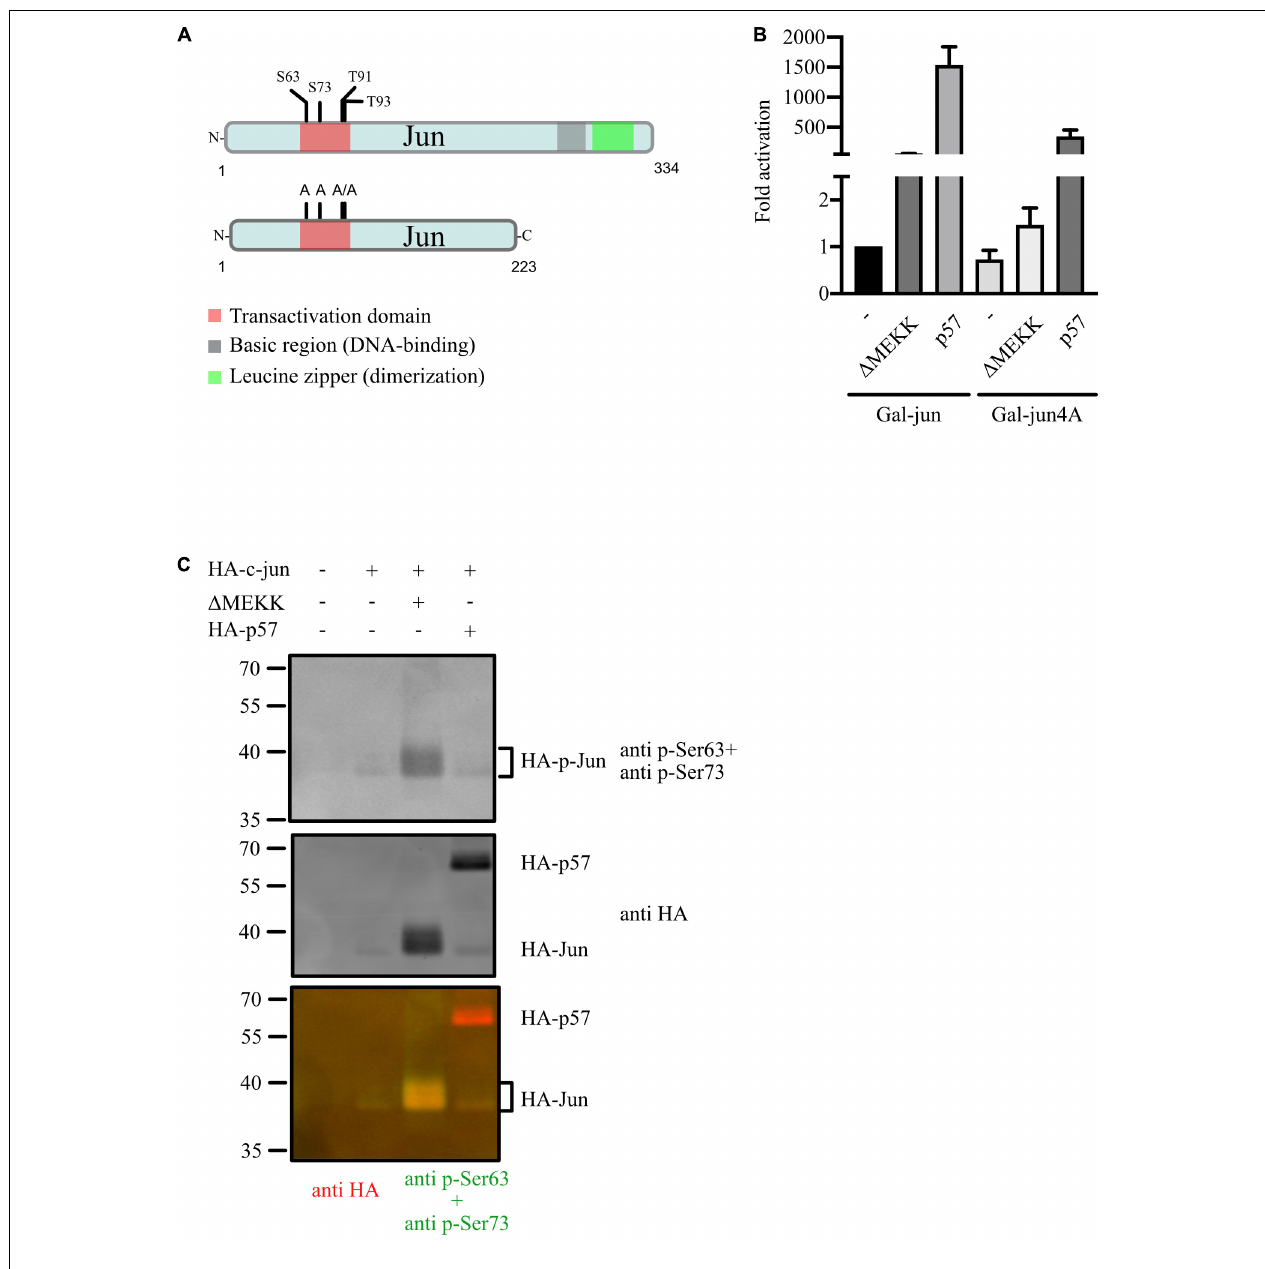
FIGURE 3 | JNK-independent activation of c-Jun by p57. (A) Schematic of human wildtype c-Jun, Gal-Jun and Gal-Jun4A mutant. Functional domains and phosphorylation sites in the transactivation domain (TAD) are indicated. A Gal4-DNA binding domain (DBD) fusion in frame to the aminoterminus of c-Jun or mutant c-Jun4A ranging from amino acids 1–223 is used in reporter gene experiments. (B) Gal4-dependent luciferase reporter gene experiments analyzing the role of the four major phosphorylation sites in the TAD of c-Jun in the activation by p57. 293FR cells were cotransfected with DNA-expression plasmids for Gal-Jun or the TAD phosphosite mutant Gal-Jun4A in absence or presence of p57 or the constitutive active upstream kinase of JNKs ( (cid:49) MEKK). pUbi-Rluc (expressing renilla luciferase) served as a transfection control. A total of 30 h after transfection cells were harvested and subjected to dual luciferase assays. Renilla-normalized values are expressed as fold activation relative to control transfected (Co.) Gal-Jun which was set to 1. For showing lower fold activations, y-axis is split into two segments (bottom: 0 to 2.5, top: 50 to 2,000). Shown are the results from three independent experiments. (C) p57 does not induce serine 63 or serine 73 phosphorylation of c-Jun. Immunoblot-analysis investigating the effect of p57 on c-Jun TAD-phosphorylation. 293 cells were transfected with expression vectors for c-Jun and p57 (both HA-tagged) or the constitutive active kinase (cid:49) MEKK. Extracts were prepared 40 h after transfection and subjected to immunoblot-analysis by the LiCor Odyssey system to visualize expression of HA-Jun and Ser 63 and Ser 73 phosphorylation simultaneously. Mixture of Ser 63 and Ser 73 phospho-specific rabbit polyclonal and anti HA mouse monoclonal antibodies were used as first antibodies followed by a mixture of goat derived secondary antibodies coupled with fluorochromes for 680 (anti mouse) or 780 nm (anti rabbit). Three images are shown. Upper: 700 nm channel, phospho-Ser 63/73; middle: 800 nm channel, HA; lower: merged pseudo-colors from channel 700 (red) and 800 (green). Note that molecular weight of HA-Jun is shifted in the presence of the constitutive active kinase (cid:49) MEKK and appears yellow in the merged